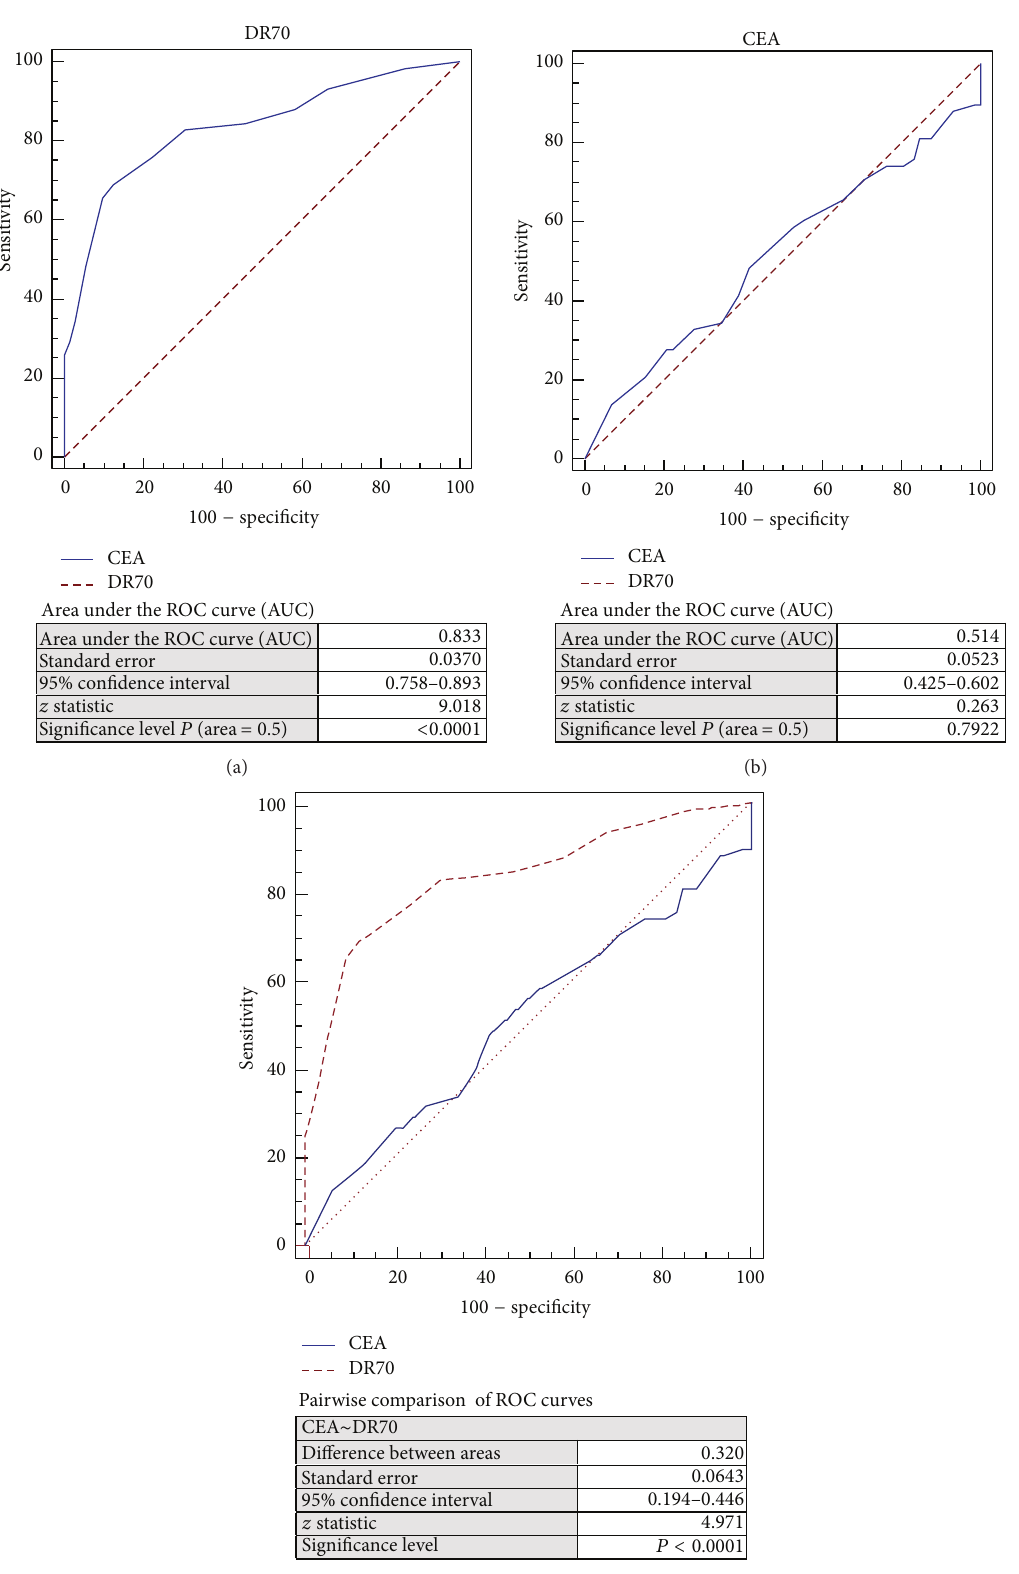
Figure 2: Receiver operating characteristic (ROC) curve for the diagnostic ability of (a) DR-70, (b) CEA, and (c) DR-70 versus CEA to differentiate low grade dysplasia from high grade